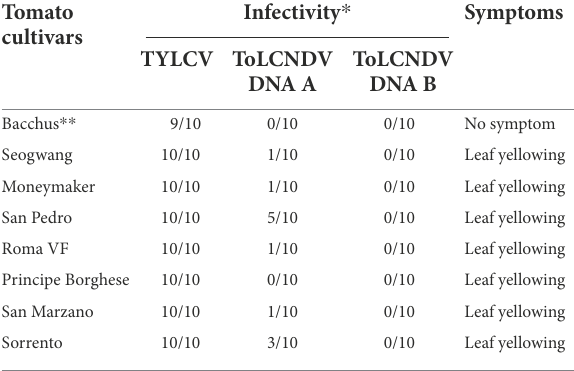
TABLE 3 Infectivity of ToLCNDV co-inoculated with TYLCV infectious clone on different tomato via PCR amplification and symptom observation at 21 dpi.